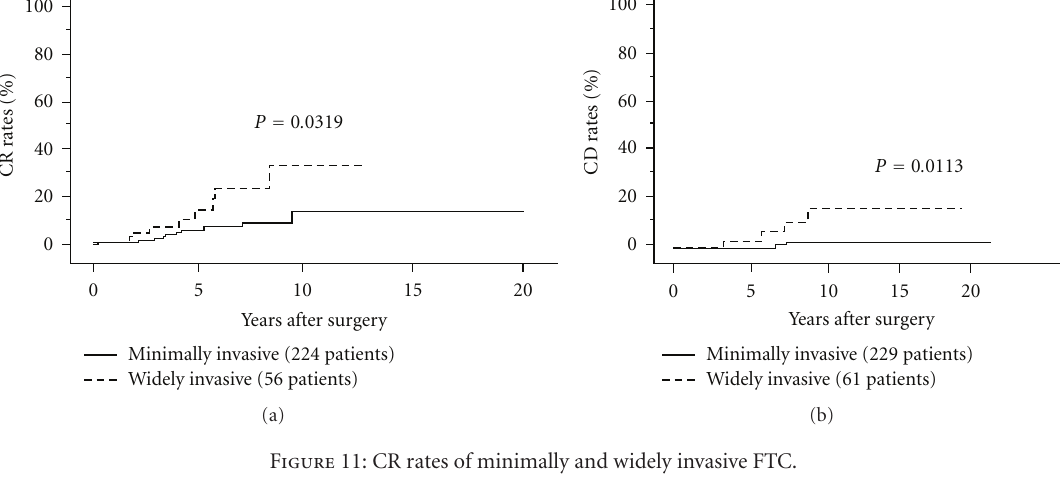
Figure 11: CR rates of minimally and widely invasive FTC.